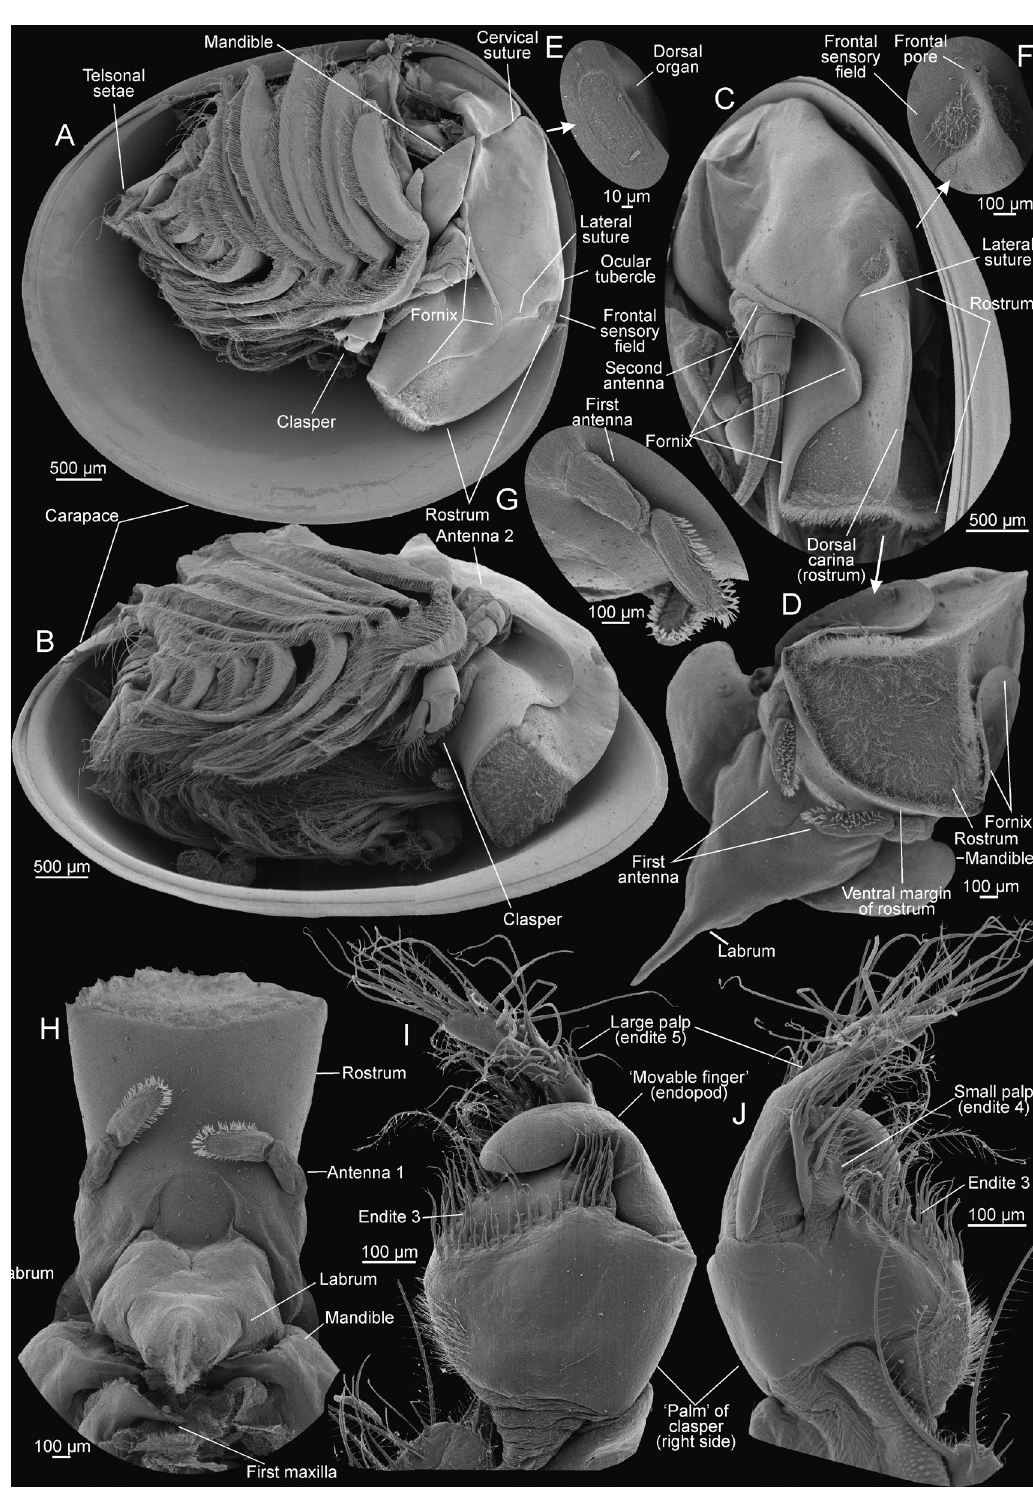
Fig. 3. Lynceus insularis sp. nov., ♂♂, scanning electron microscopy (paratypes, ZMUC-CRU-4787). A . Right lateral view with carapace valve removed. B . Right ventrolateral view with carapace valve removed. C . Head and rostrum, anterior view. D . Rostrum/labrum, anterior view. E . Dorsal organ. F . Frontal sensory fields. G . First antenna, right side. H . Rostrum, labrum and first antennae from posterior. I . Clasper, right side seen from anterior. J . Clasper, right side seen from